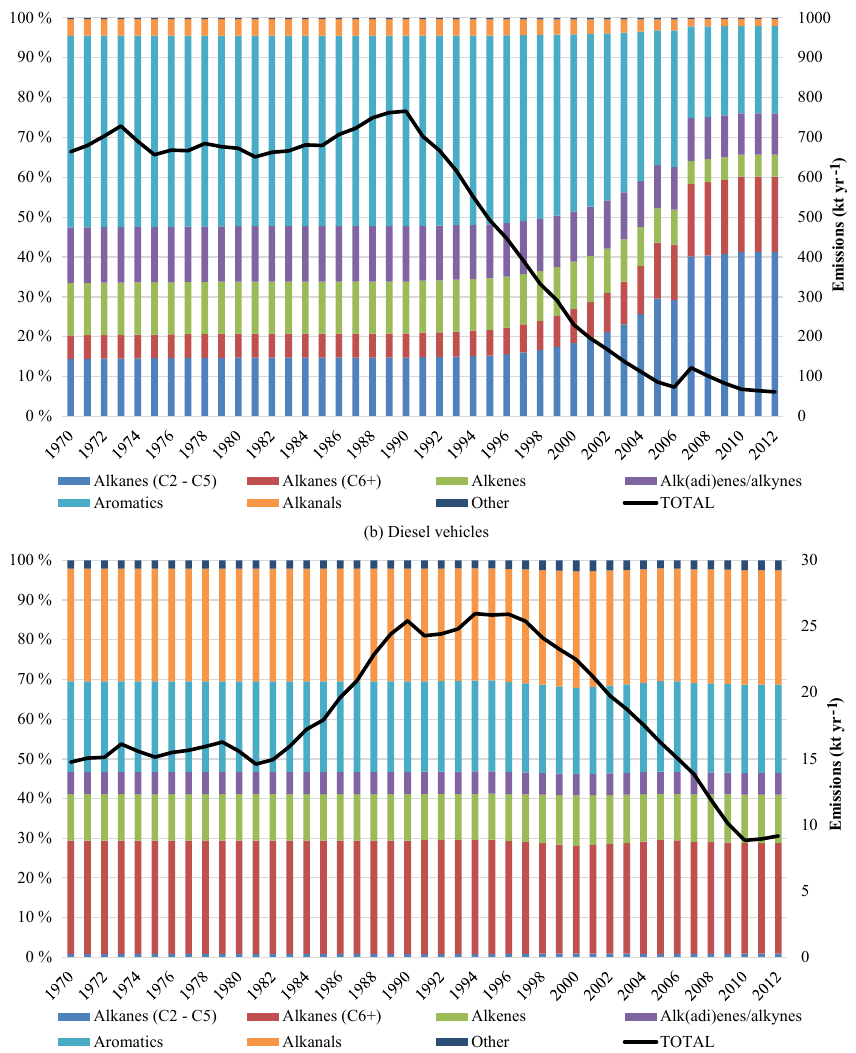
Figure 6. Total NMVOC combustion emissions and their speciation for (a) petrol vehicles and (b) diesel vehicles of the road transport sector in the UK during